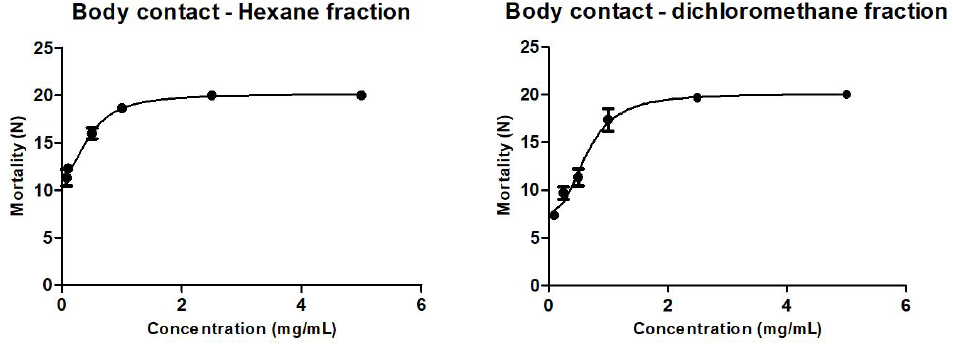
Figure 8. Dose-response curve of mortality (n) of Aedes aegypti adult (body contact) versus concentrations (mg/mL) of fractions of Helicteres velutina after 48 hours. The LC 50 and LC90 were calculated using non-linear regression, considering a 95% significance